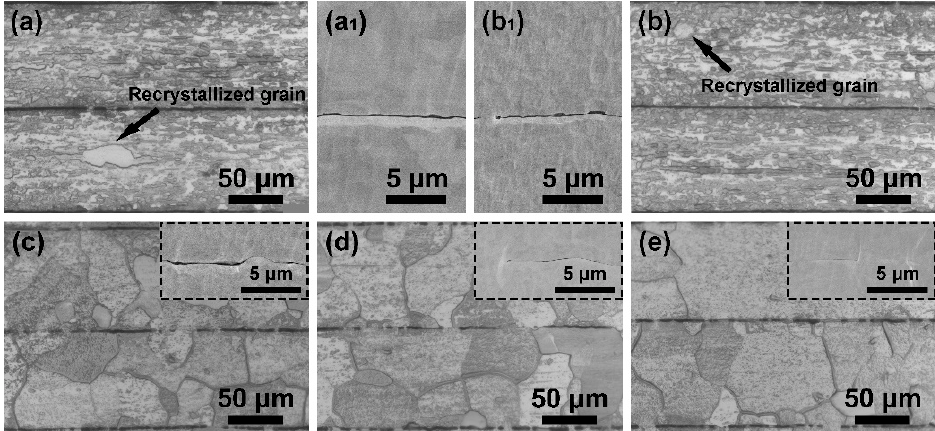
Figure 6. The metallographic structures viewed from transverse direction of the W foil laminates joined at different temperatures ( a ) 600 °C, ( b ) 800 °C, ( c ) 1000 °C, ( d ) 1200 °C, and ( e ) 1400 °C. ( a 1 ), ( b 1 ) and the insert images are the SEM images of the corresponding interfaces.